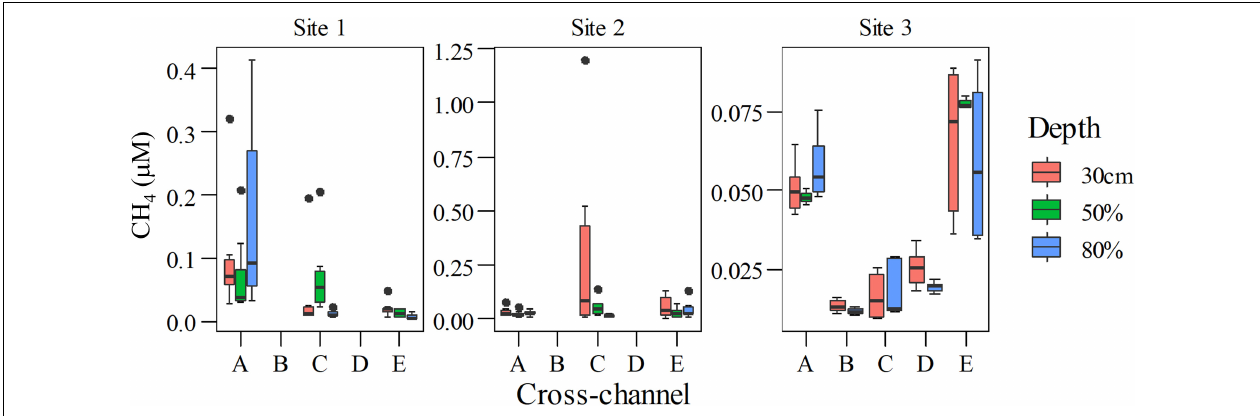
FIGURE 3 | Cross-channel profiles of dissolved CH 4 at different depths. Note that at Site 3 measurements at 50% depth were done only in site A and E. Note different values in the y